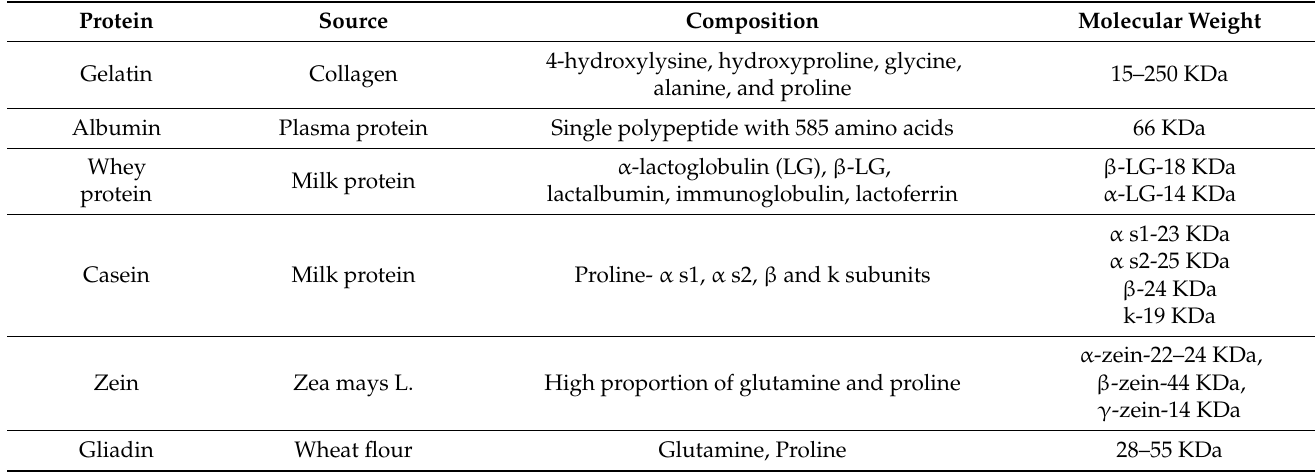
Table 4. Physicochemical properties of different